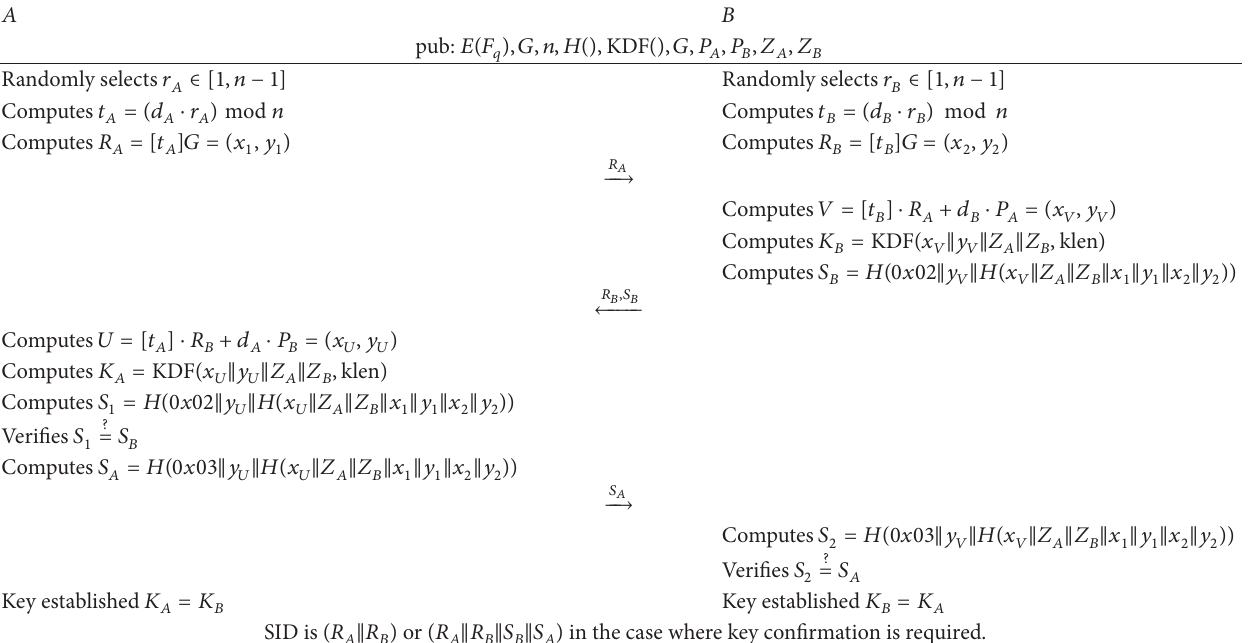
Table 2: Simplified SM2 key exchange